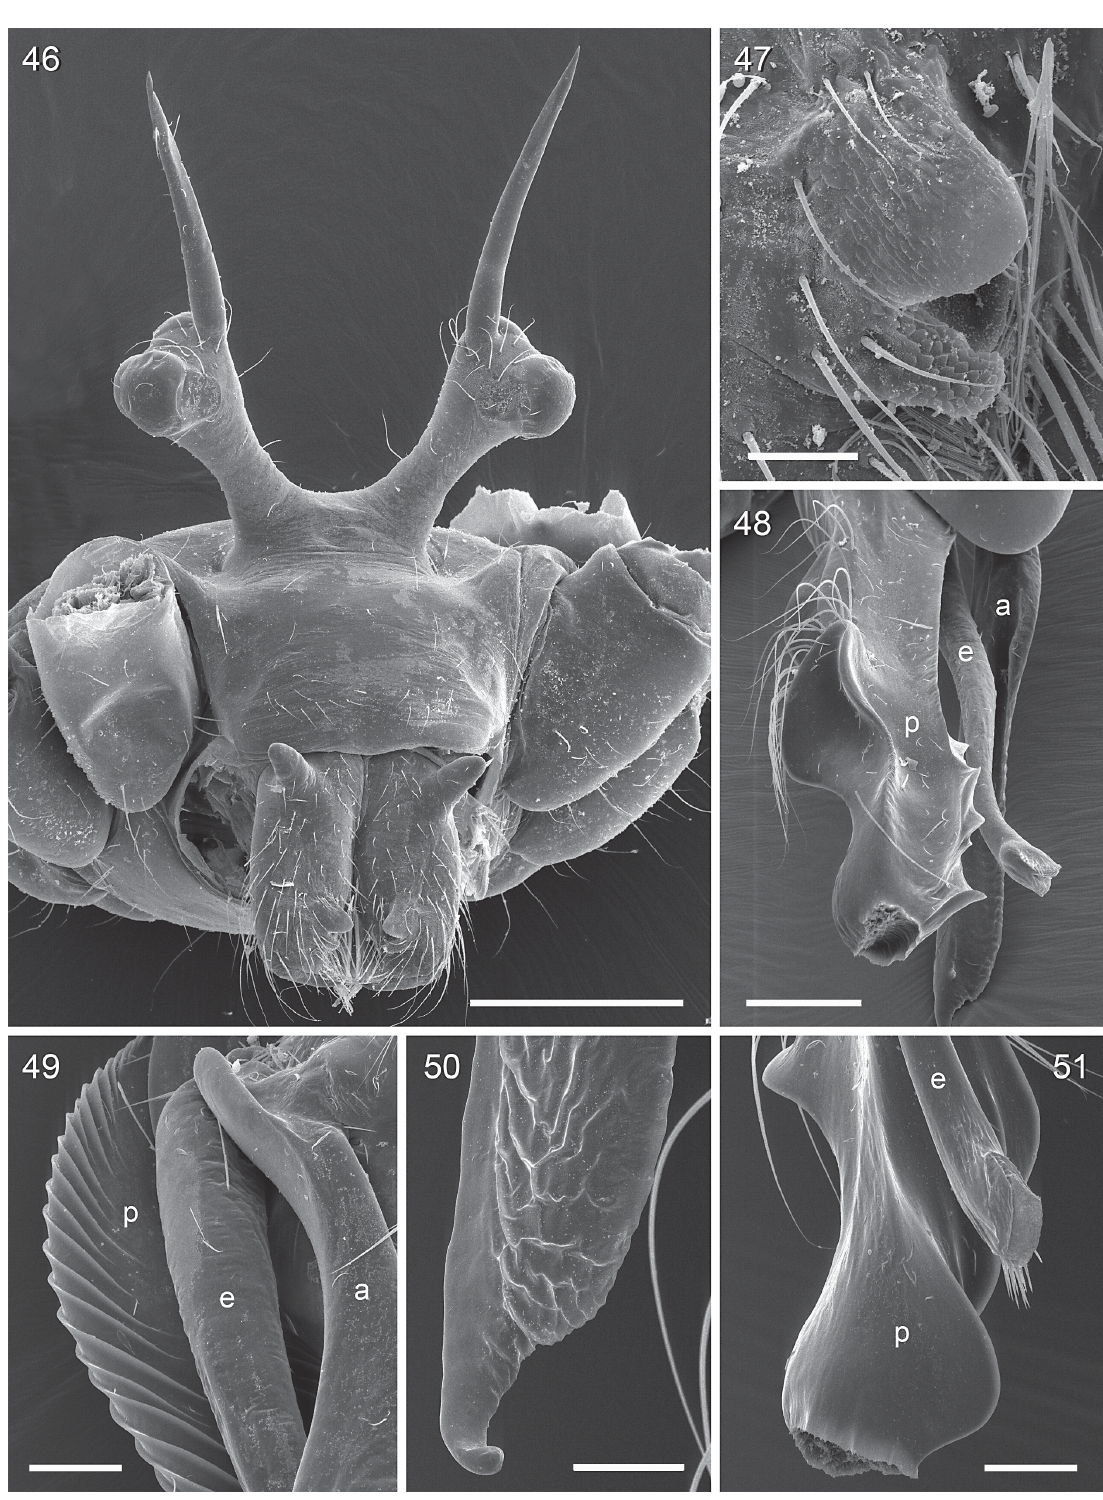
Figs 46–51. Panjange kapit Huber, sp. nov. (ZFMK Ar 14583). 46 . Male prosoma, frontal view. 47 . Right distal male cheliceral apophysis. 48 . Right procursus (and bulbal processes), dorsal view. 49 . Ridges on left procursus, prolateral view. 50 . Tip of left appendix, prolateral view. 51 . Tip of left procursus (and embolus), ventral view. Abbreviations: a = appendix; e = embolus; p = procursus. Scale lines: 30 µm (47); 60 µm (50); 100 µm (49, 51); 200 µm (48); 400 µm